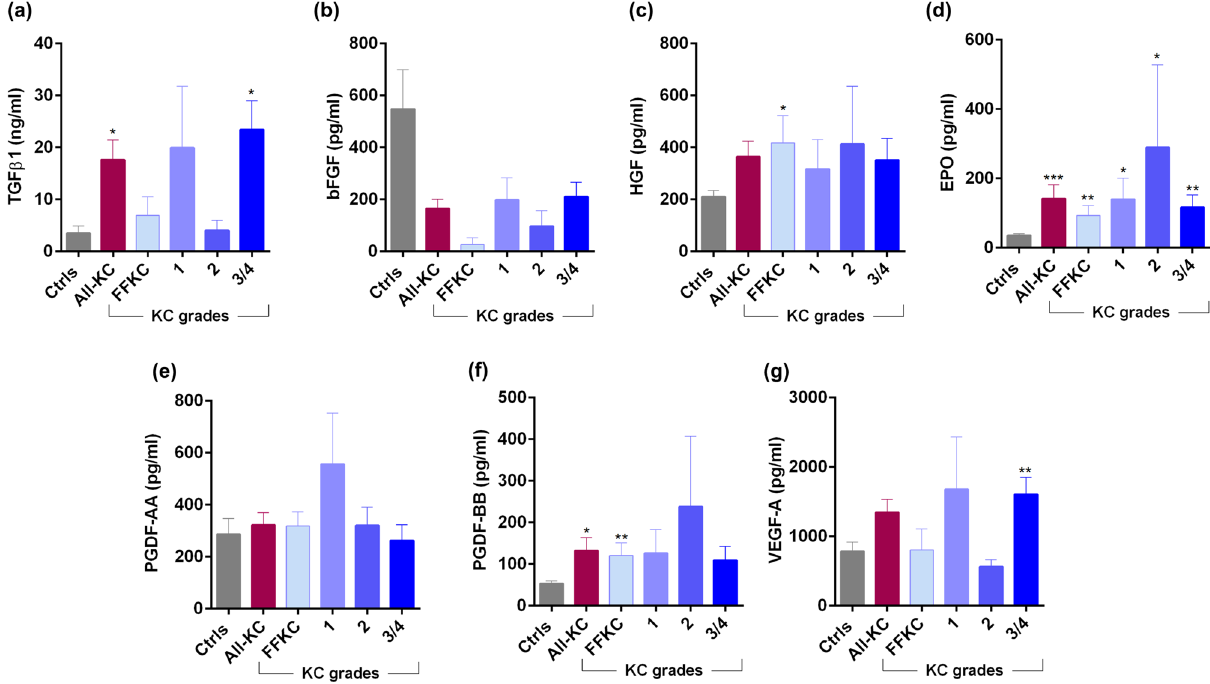
Figure 5. Tear fluid growth factors level in KC patients: The graphs indicate the concentration of TGFβ1 ( a ), bFGF ( b ), HGF ( c ), EPO ( d ), PDGF-AA ( e ), PDGF-BB ( f ) and VEGF-A ( g ) in the tear fluid of subjects with different grades of KC. Ctrls—Controls; All-KC—all the grades of keratoconus combined; FFKC—Forme fruste keratoconus; bFGF—basic fibroblast growth factor; HGF—Hepatocyte growth factor; EPO—erythropoietin; PDGF—Platelet-derived growth factor; TGFb1—Transforming Growth Factor Beta 1; VEGF—Vascular endothelial growth factor; SEM—standard error of the mean; Controls (20 eyes), All-KC (41 eyes), FFKC (6 eyes), grade 1 KC (6 eyes), grade 2 KC (6 eyes), grade 3 or 4 (23 eyes); Bar graphs represent Mean ± SEM; *P < 0.05, **P < 0.01,***P < 0.001, ****P < 0.0001, Mann–Whitney